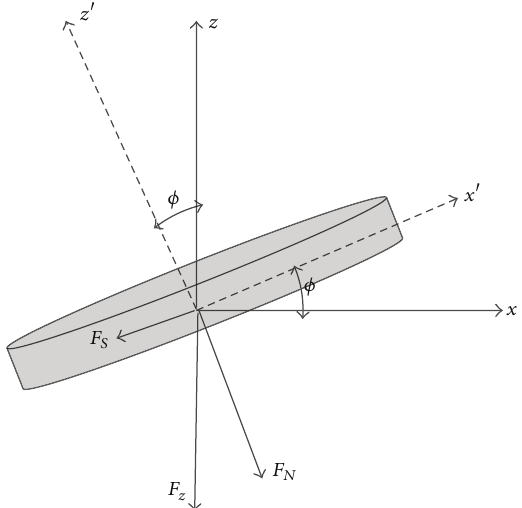
Figure 3: Decomposition of the applied load on a spot weld into the axial and the shear component at the loading angle of 𝜙